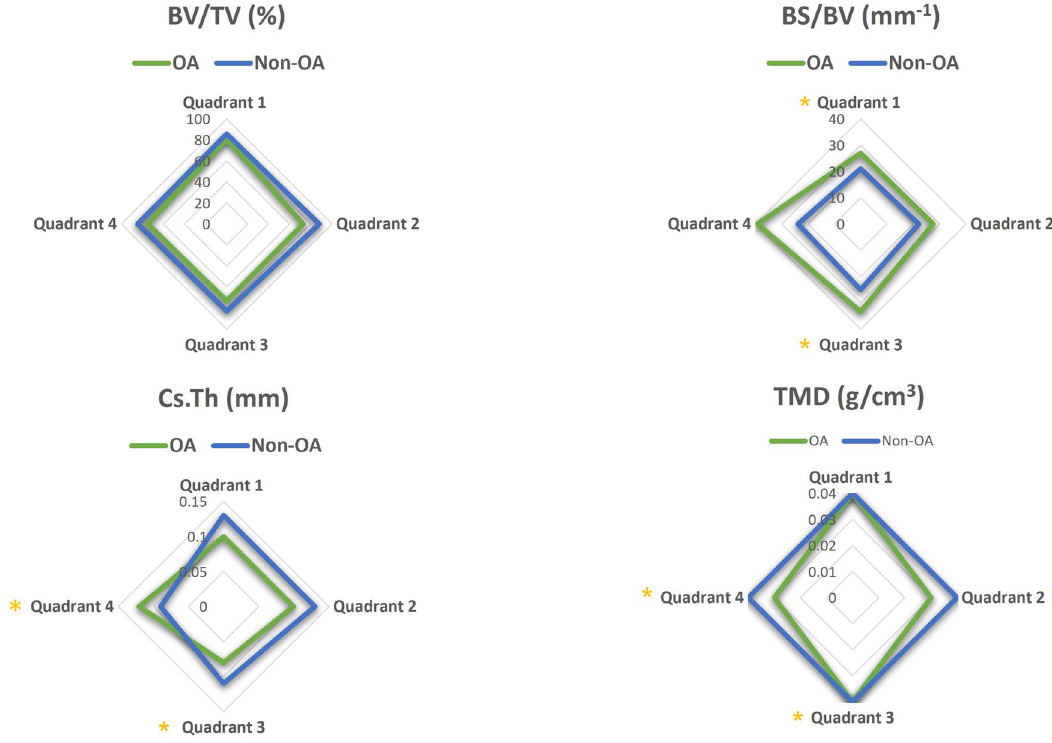
Figure 7. Regional distribution of the median value for the cortical plate microstructural properties in the OA (green) and non-OA (blue) patients. No significant differences were found when cortical plate in different anatomical regions was compared within the OA and non-OA patients. (*) shows when there is a significant difference between OA and non-OA patients ( p < 0.05). BV/TV: bone volume fraction; BS/BV: specific bone surface; Cs.Th: cortical thickness; TMD: tissue mineral density.